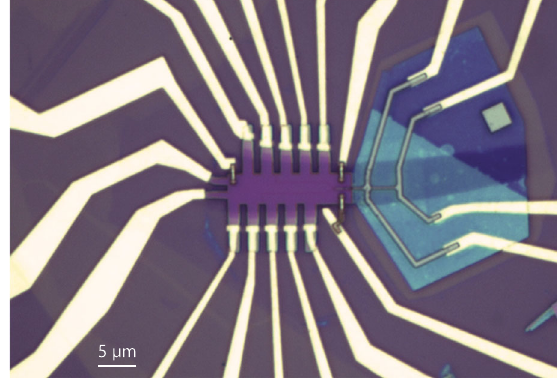
FIG. 6. The presented devices. Data presented in Figs. 1 – 3,5,15,16 are taken from device 1; Figs. 4,8 – 14 are taken on device 2. The superconductor in device 1 is ∼ 1 μ m long resulting in a ∼ 2 - μ m-long graphene-superconductor interface. The super- conductor in device 2 is ∼ 2 μ m long, which results in a ∼ 4 - μ m- long interface. No systematic dependence of p face length has been observed. The width of the superconductor is < 100 nm in both devices.